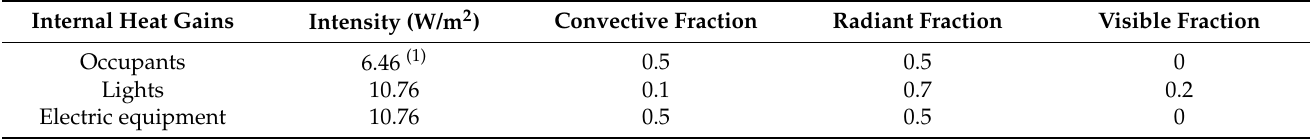
Table 3. The hourly schedules of occupancy, lighting, and electric equipment are shown in Figure 2. Table 3. Detailed inputs for internal heat gains. Reproduced from [31], National Renewable Energy Laboratory: 2011. Internal Heat